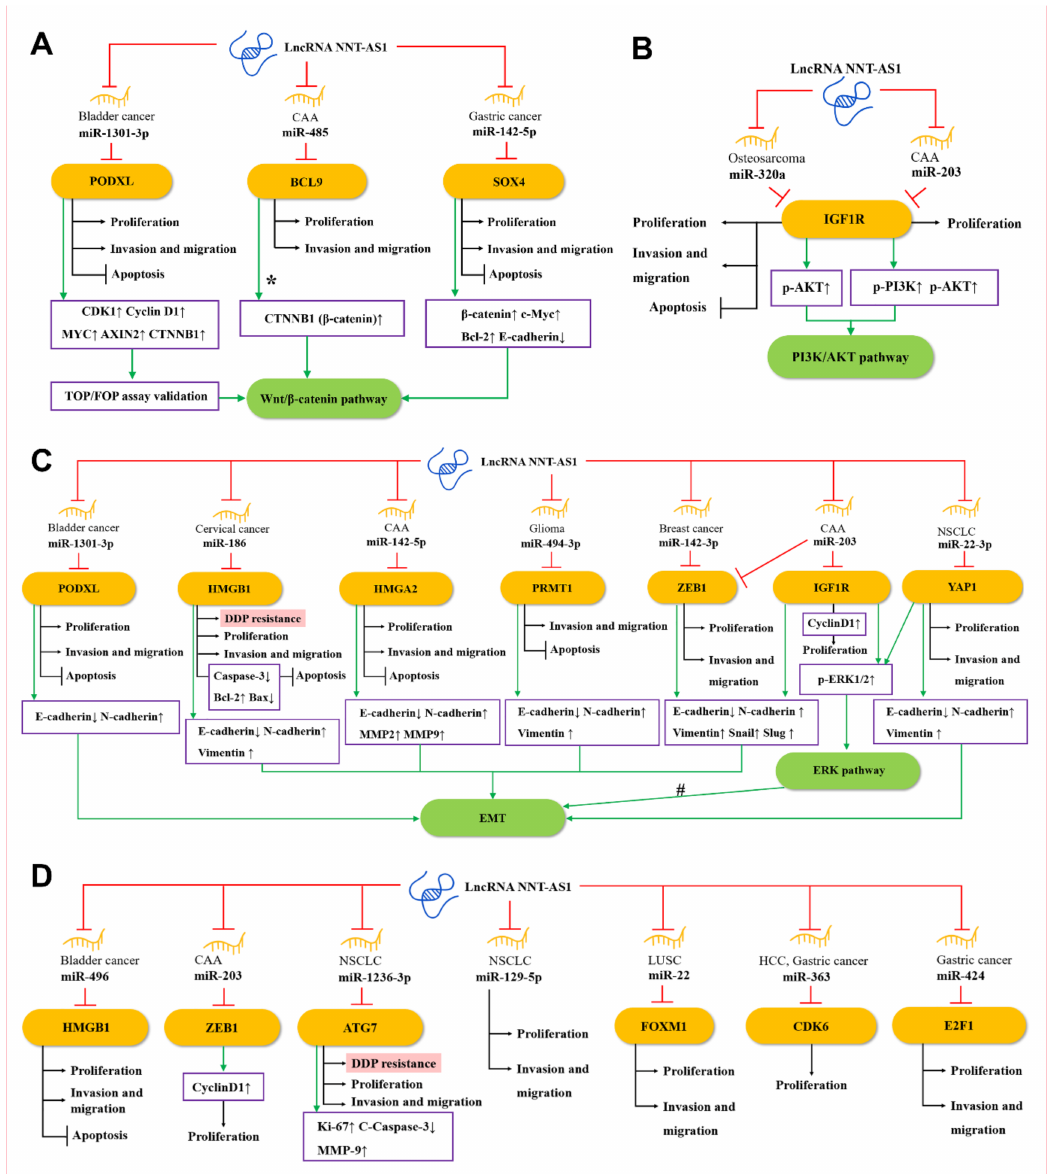
Figure 2. The competing endogenous RNA (ceRNA) mechanisms and potential downstream regulatory mechanisms of NNT-AS1. By sponging miRNAs, NNT-AS1 downregulates these miRNAs and influences downstream targets as well as ( A ) the Wnt / β –catenin pathway, ( B ) the PI3K / AKT signaling pathway, ( C ) the EMT and ERK signaling pathways, and ( D ) other ceRNA mechanisms, thereby a ff ecting DDP resistance, proliferation, invasion, and metastasis, or inhibiting apoptosis of tumor cells. #: NNT-AS1 / miR-22-3p is likely to regulate EMT through the YAP1-mediated ERK pathway. CCA, cholangiocarcinoma; NSCLC, non-small-cell lung cancer; LUSC, lung squamous cell carcinoma; HCC, hepatocellular carcinoma; EMT, epithelial–mesenchymal transition; DDP,